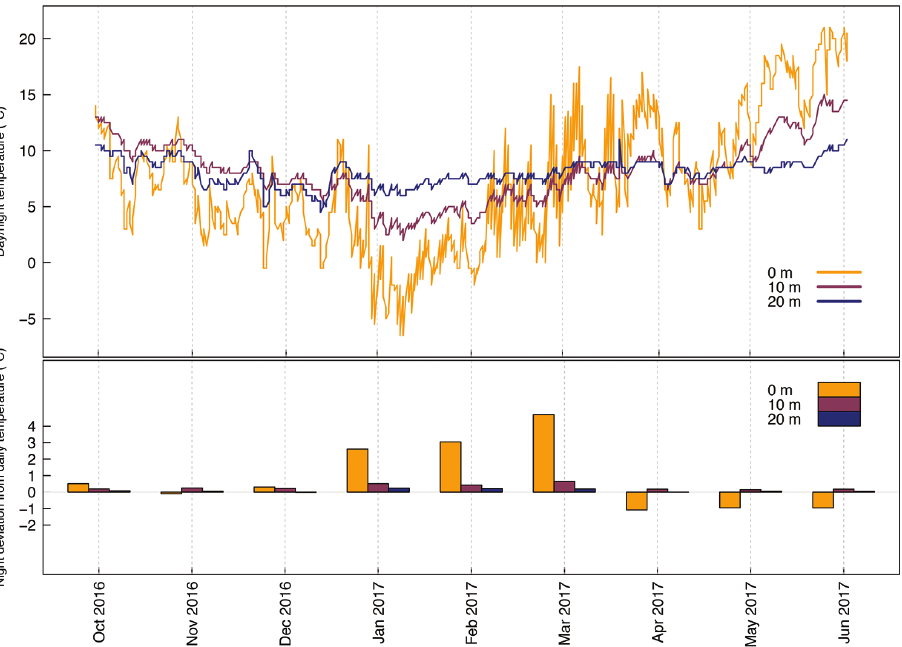
Figure 2. Temperature variation in the study area. Data refer to record of temperature and relative hu- midity measured every 12 h (one measurement at midday and one at midnight). Top panel: annual trends of temperatures measured at the entrance (0 m; orange line) and inside the mine (10 and 20 m; purple and blue lines, respectively). Bottom panel: mean of monthly positive and negative temperature deviations at night, with respect to the daily temperature recorded during the same